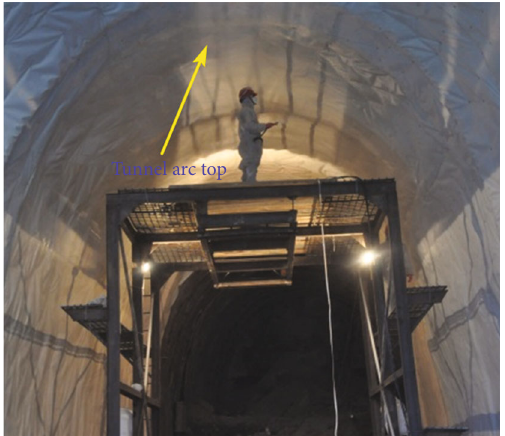
Figure 2: LNG technical tunnel under construction in